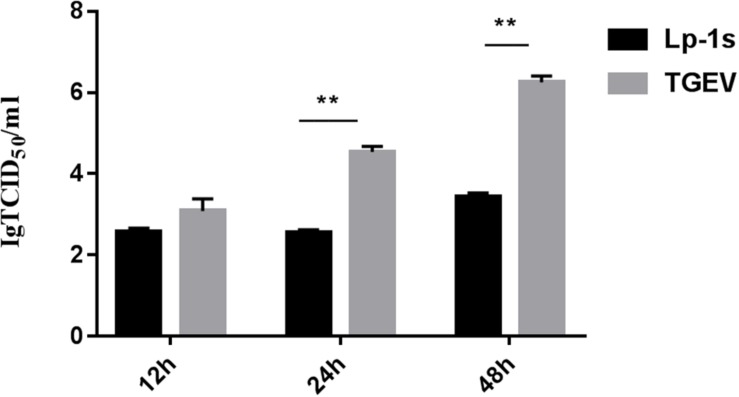
TCID50 analysis. The results of statistical analysis showed that the 24 h and 48 h Lp-1s supernatant treatment groups had significantly different TCID50 values compared with that of the simultaneous TGEV challenge group (∗∗P < 0.01) demonstrating that IPEC-J2 had a reduced viral titer of the TGEV Miller strain after treatment with Lp-1s.